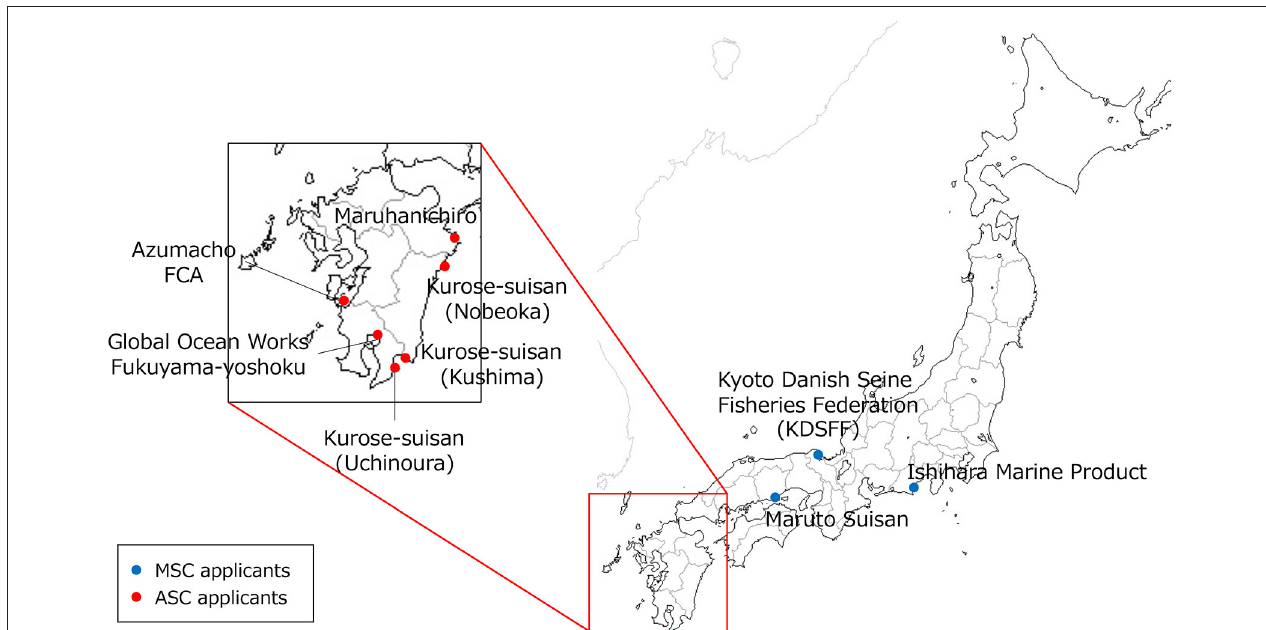
FIGURE 1 | Location of MSC/ASC